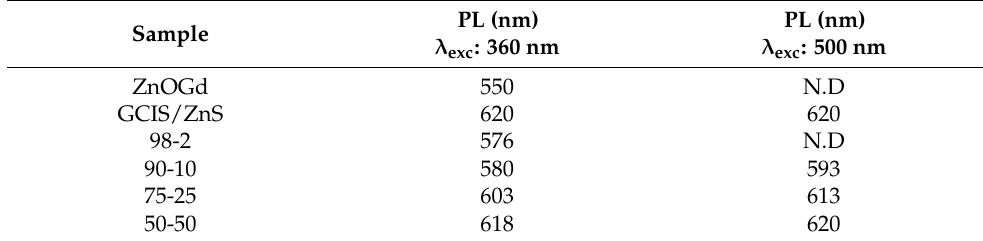
Figure 1. Excitation (PLE) — ( a ), and emission (PL) spectra of Qdot powders after excitation at 360 nm ( b ) and 500 nm ( c ). Table 2. Photoluminescence (PL) spectra of Qdot powders.